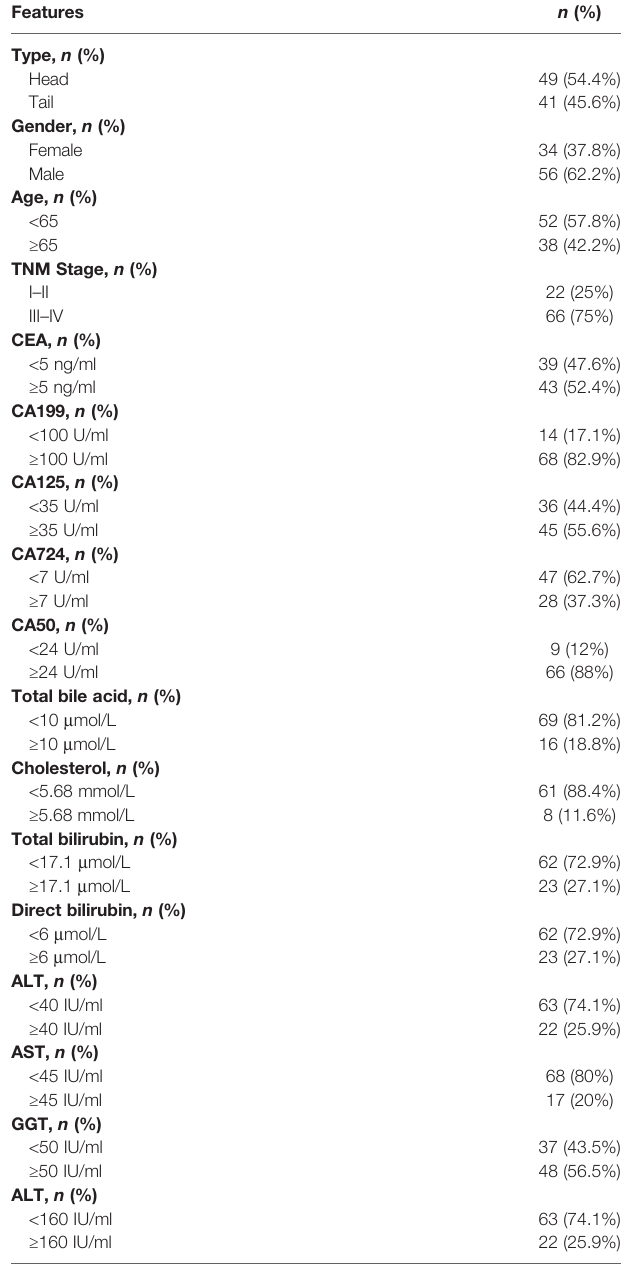
TABLE 1 | Clinical features and detection indicators of PDAC patients in the peripheral blood samples.